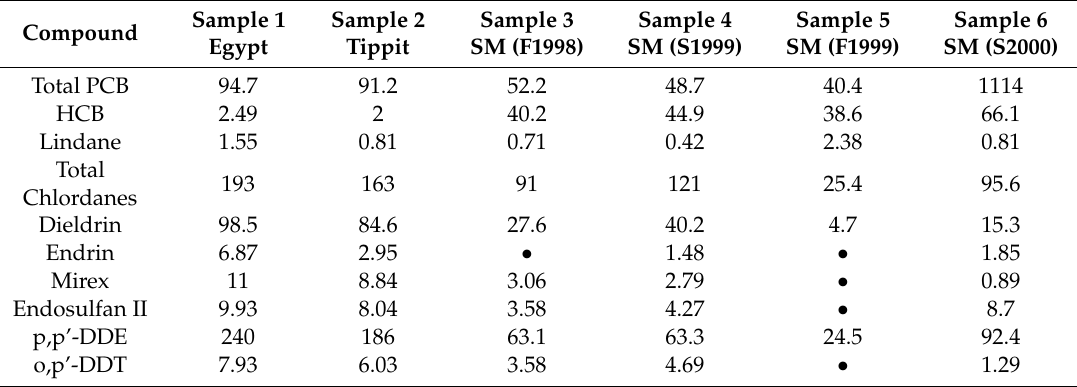
Table 2. Organochlorines (ppb) in guano from Shell Mountain (SM), Egypt, and Tippit Caves. Only Shell Mountain had an active bat colony and was sampled in four di ff erent seasons. F = Fall and S = Spring. Dots represent non-reported numerical values that were either below minimum detection level, subject to interference, or not